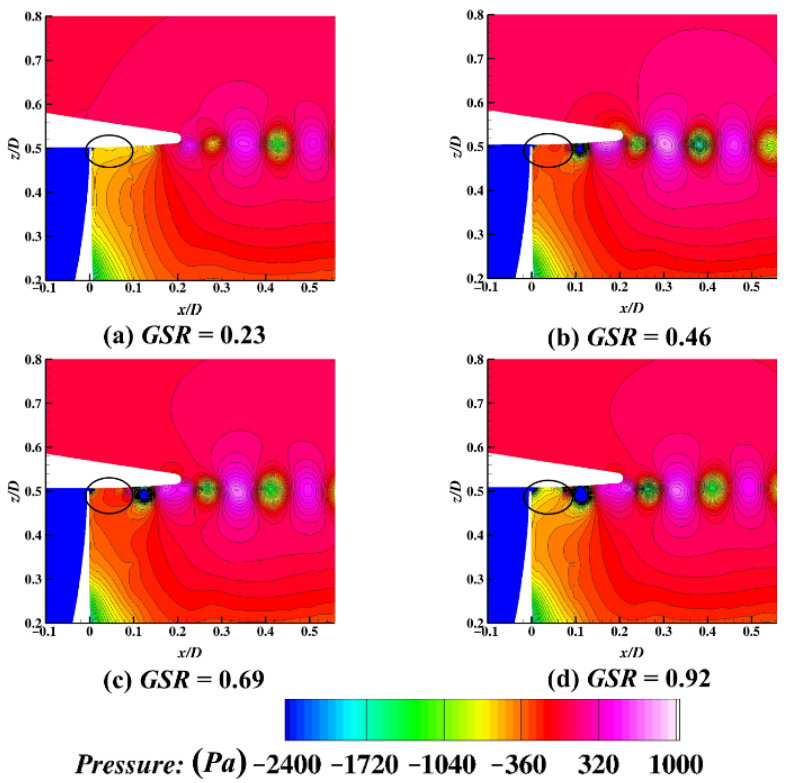
Figure 12. Side view of pressure near the tip clearance of four groups of ducted propellers with different GSRs. different